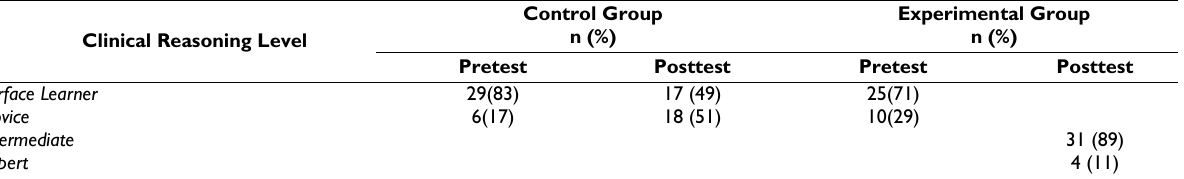
Table 3. Level of Clinical Reasoning (n =